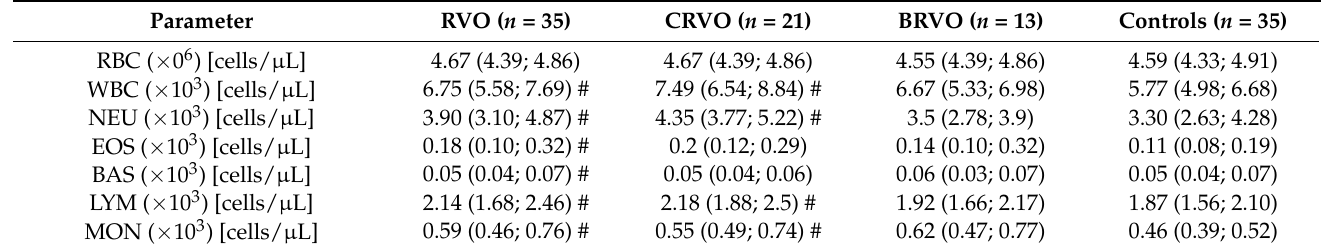
Table 2. Basic parameters of peripheral blood morphology in RVO patients and controls.